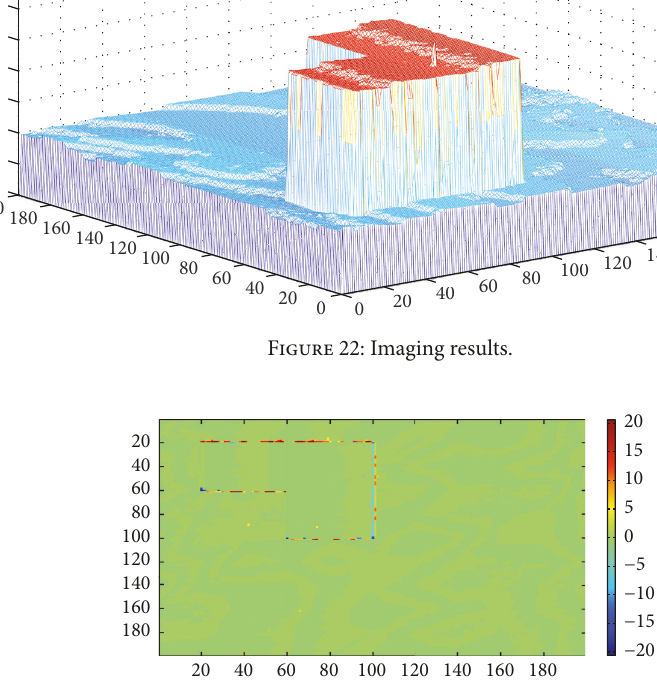
Figure 23: Difference